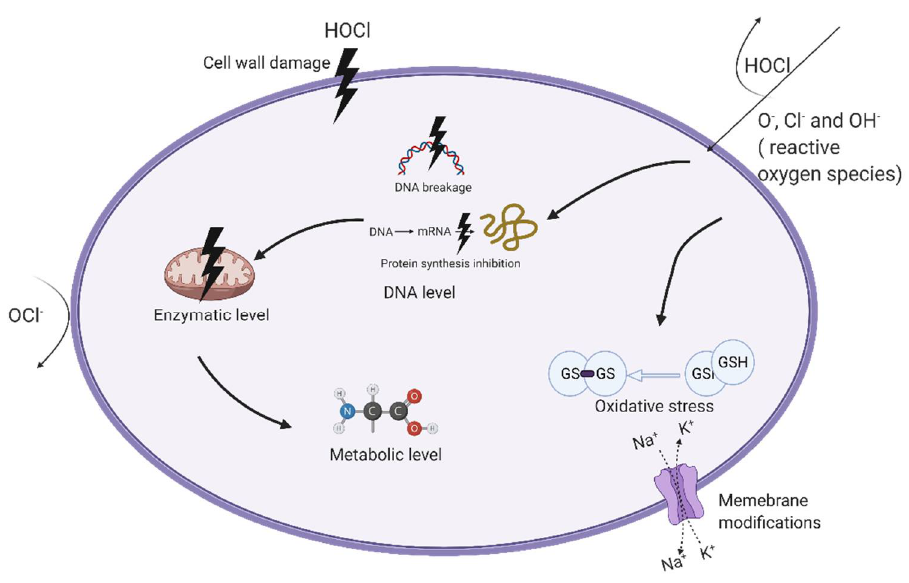
Figure 2. The germicidal mechanisms of EW on microorganisms. ClO − , Cl − , and OH − attack only on the cell wall and outer membrane of the cell. HOCl can penetrate the cell membrane’s lipid bilayer. EW attacking various cellular targets including cytoderm, intracellular components, and outer membrane. HOCl disordered intracellular components, normal cellular functions, and bacterial ultrastructures in various degrees including complex changes of intracellular metabolites, metabolic pathway (enzymatic level), and intracellular microenvironment (membrane integrity).